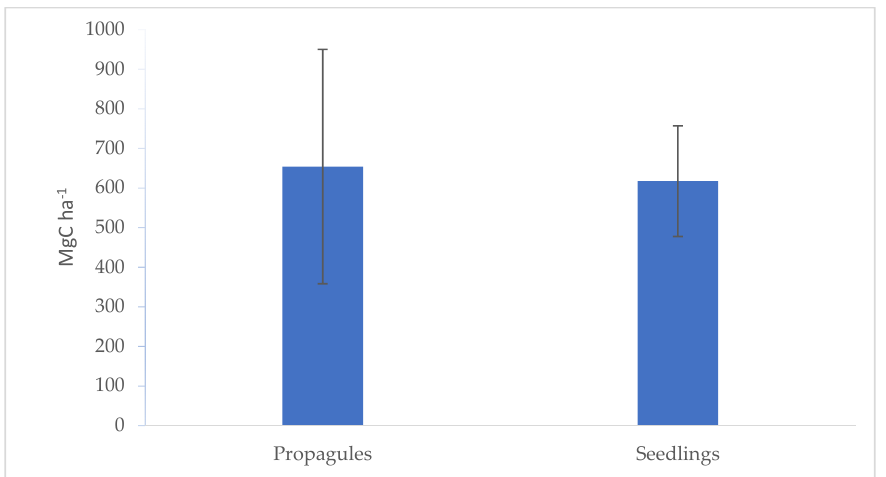
Figure 5. Soil carbon stocks in two planted approaches in rehabilitated aquaculture ponds of Lubuk Kertang.